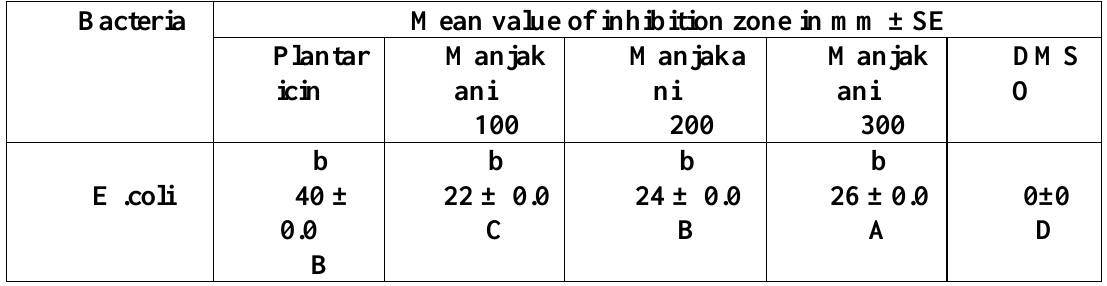
Table (3): In vitro antibacterial activity of Manjakani &Plantaricin Bacteria